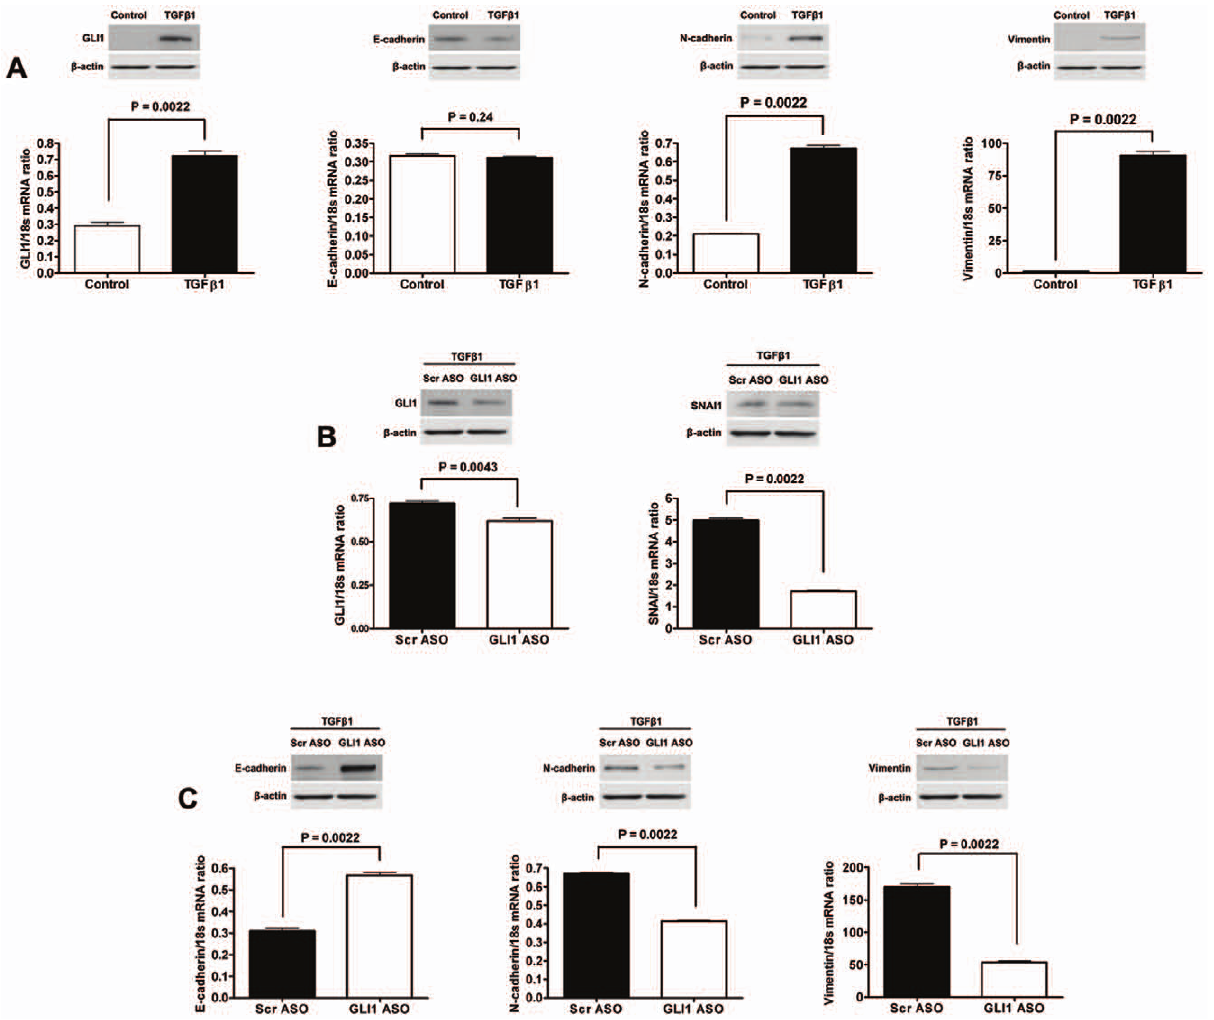
Figure 7. GLI1 is induced by TGF b 1 and mediates the mechanism by which TGF b 1 induces EMT in HCC cells. (A) TGF b 1 increases GLI1 expression in Huh7 cells. And TGF b 1 is also found to decrease E-cadherin expression, while increasing the expression of N-cadherin, Vimentin and SNAI1 in Huh7 cells. (B) Suppressing the TGF b 1 induced up-regulation of GLI1 in Huh7 cells by GLI1 ASO decreased the expression of both GLI1 and SNAI1 in Huh7 cells. (C) Suppressing the TGF b 1 induced up-regulation of GLI1 in Huh7 cells by GLI1 ASO increases E-cadherin expression and decreases the expression of both N-cadherin and Vimentin.